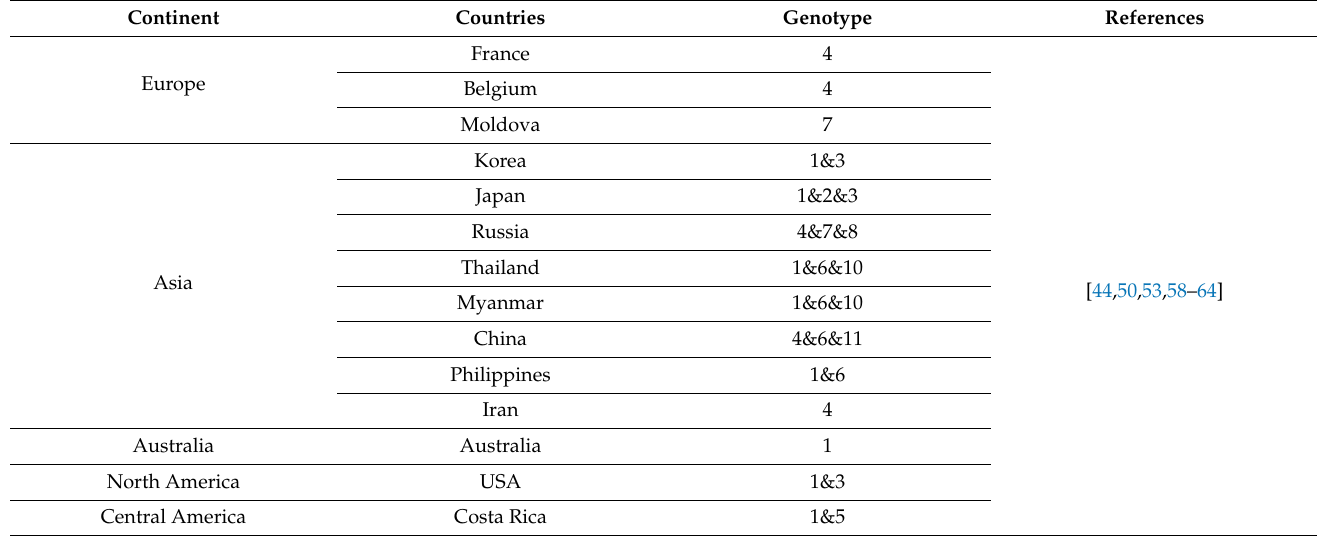
Table 1. BLV Genotyping based on partial BLV env sequences identified in geographical locations around the world.